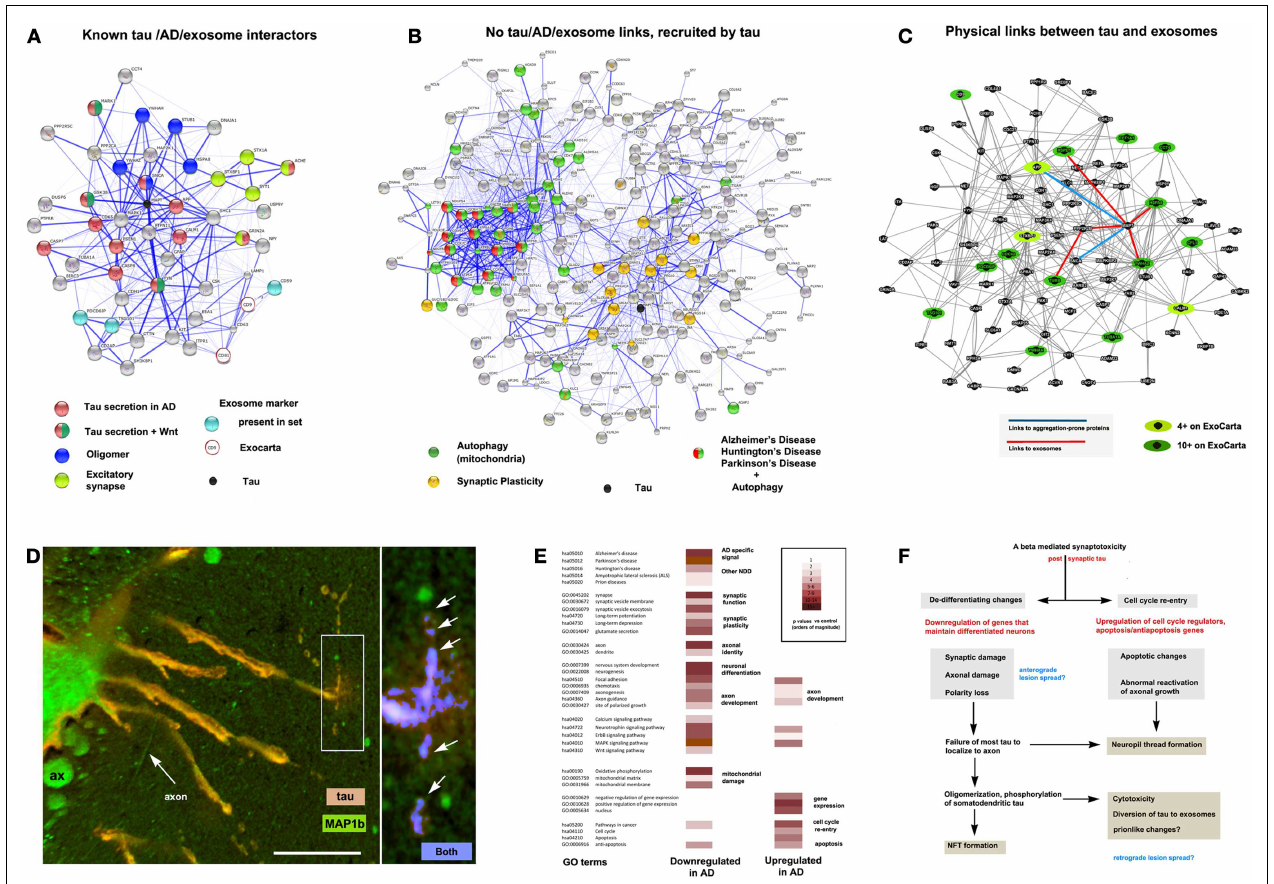
mammalian exosomal datasets at ExoCarta. Links between tau and highly exosome associate proteins (dark green icons), mildly exosome associated (light green icons), and aggregation-prone proteins such as SNCA and APP (Abeta) are shown as well to illustrate the plausibility of tau diversion to exosomes in the context of these co-purified proteins. (D) Expression of 4R0N tau in lamprey ABCs produces dendritic localization of tau (red channel), dendritic degeneration, and localized focal secretion (left box, orange label) as shown in a confocal micrograph after 10days of expression (81). Immunolabel for LC3/MAP1b (green channel) shows cytoskeletal localization in non-transfected giant axons (seen in cross section – ax), and in circumferential axons (arrow axon). One of the latter has taken up secreted tau shown at higher magnification (right) and is exhibiting toxicity in the form of varicosities (arrows) similar to those shown in ABC dendrites (dendrite, center). Highly co-localized tau (blue channel) shows cleaved, autophagosome-associated LC3II associated with tau (arrows) in a pattern similar to that seen for dendritic mitochondria in Figure 1B . Scale bar: 50 µ (left), 10 µ (right). (E) Consensus sets of 1575 downregulated and 1383 upregulated proteins in both LOAD (238) and early onset FAD (237). (F) Schematic outlining a hypothesis of AD cytopathogenesis that accounts for tau associated exosomal secretion and downregulation of synaptic and axonal proteins in AD (red) in the context of current knowledge. Likely triggers for tau secretion and trans-synaptic lesion spreading (blue) may occur either directly from the axon due to loss of axonal MT integrity and secretion regulation, or indirectly from dendrites as the results of toxicity caused by somatodendritic tau